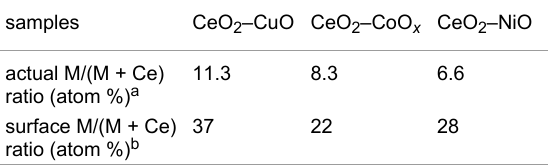
Table 1: Chemical composition of the CeO 2 –MO x composite yolk–shell nanospheres calculated from ICP-MS and XPS